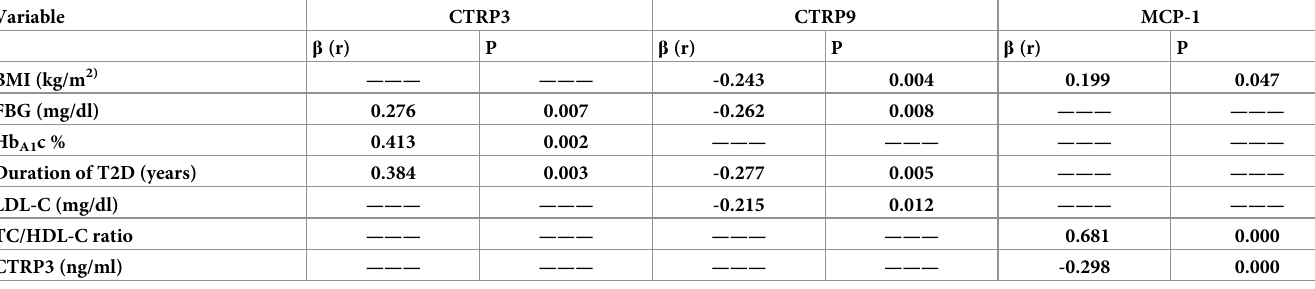
Table 3. Multiple linear regression CTRP3, CTRP9 and MCP-1 as dependant